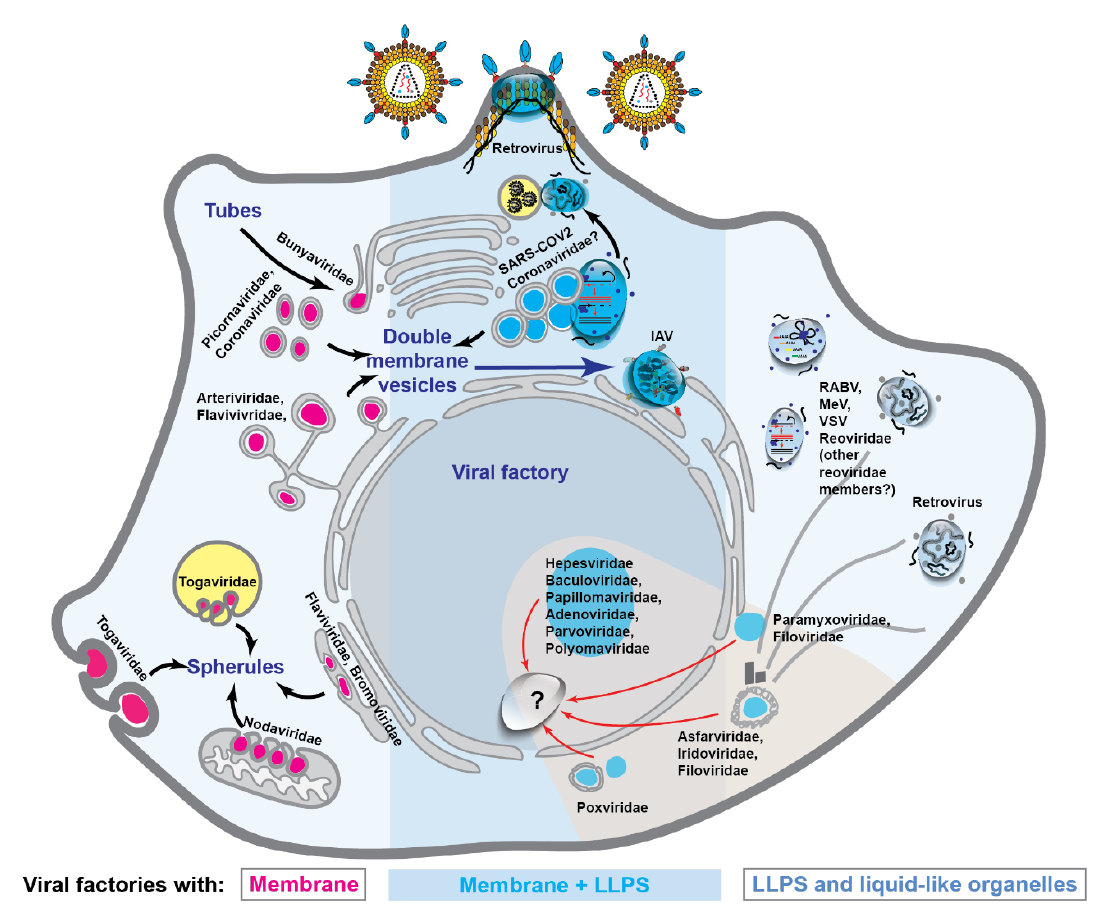
Figure 4. Viral infections reorganize cellular structure and organization. Seminal studies have shown several examples of viruses that re-shape membrane-bound organelles to facilitate their replication, which are depicted in the left side of the figure. Recent reports suggest that viruses may also induce the de novo formation of other types of cellular compartments, which lack delimiting membranes and display the properties of liquids, and that will be discussed in the next sections of this review. Interestingly, several viruses such as reovirus, influenza A virus (IAV), human immunodeficiency virus-1 (HIV), and severe acute respiratory syndrome coronavirus-2 (SARS-CoV-2) show an intimate association between the two types of cellular organelles, and the membrane interface has been shown to actively modulate protein LLPS in several ways. It has been shown to lower Csat for protein LLPS by restricting the movement of drivers and clients and even by operating as platforms for multivalent interactions. Additionally, it can build special environments to enable function; it can amplify signal transduction and even facilitate the fusion and fission of condensates, increasing their dynamics and avoiding that they reach